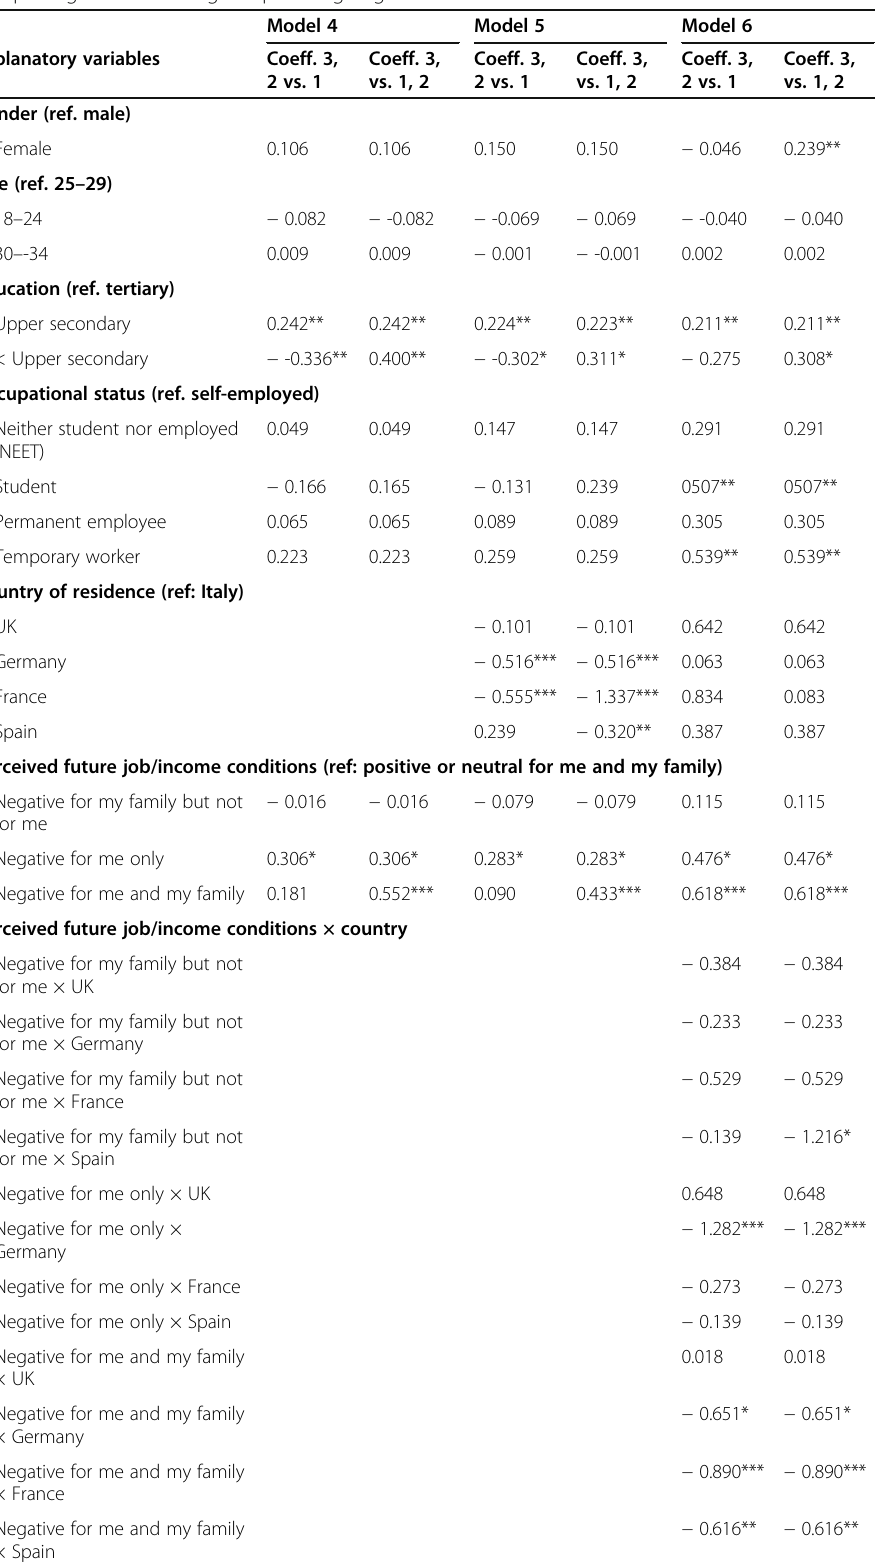
Table 5 Results of generalized ordered logistic regression for the determinants of the decision of postponing or abandoning the plan of going to live on their own